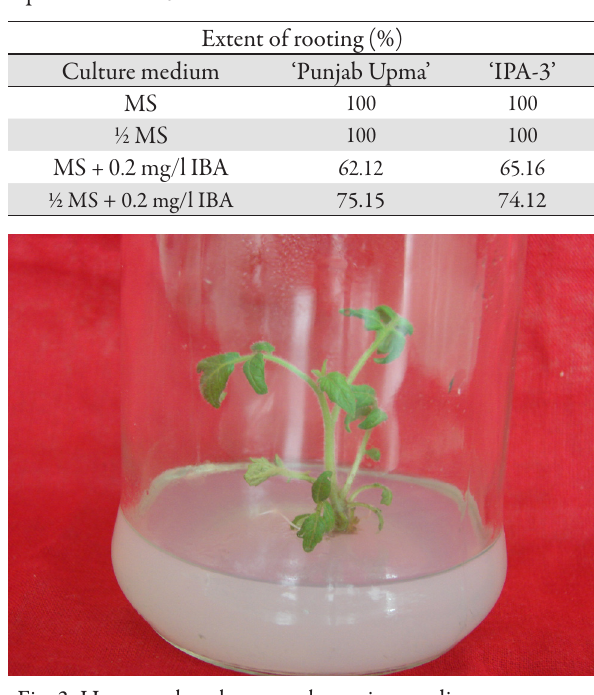
Fig. 3. Hypocotyl explants on elongation medium